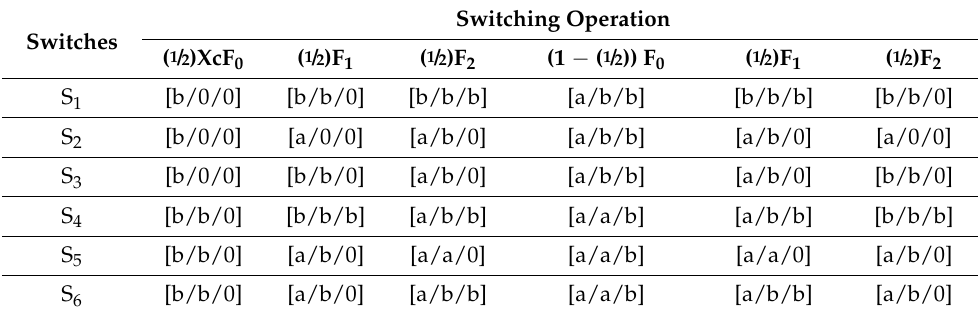
Table 2. Modes of Switching Sequence [11].